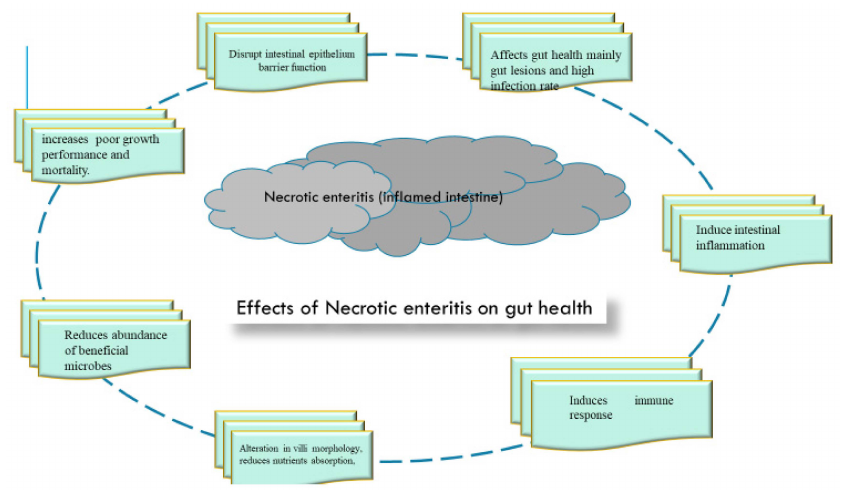
Figure 2. Diagrammatic representation of NE challenge effects on gut